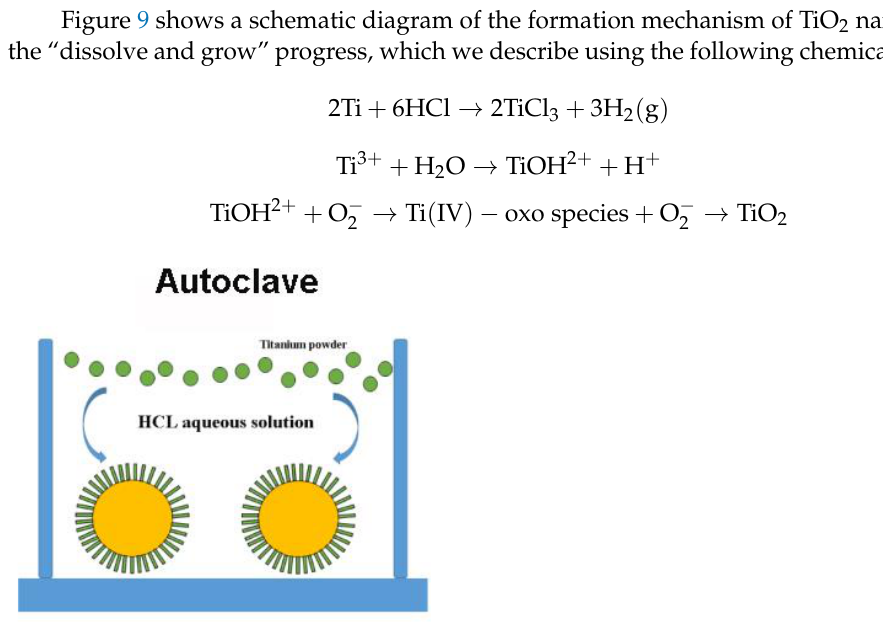
Figure 8. UV – Vis absorption spectra of methylene blue (MB) as a function of UV-light irradiation time ( λ = 365 nm) in the presence of the PI/TiO 2 @MoS 2 composites fiber (left); MB concentration changes with the as-prepared samples (right).